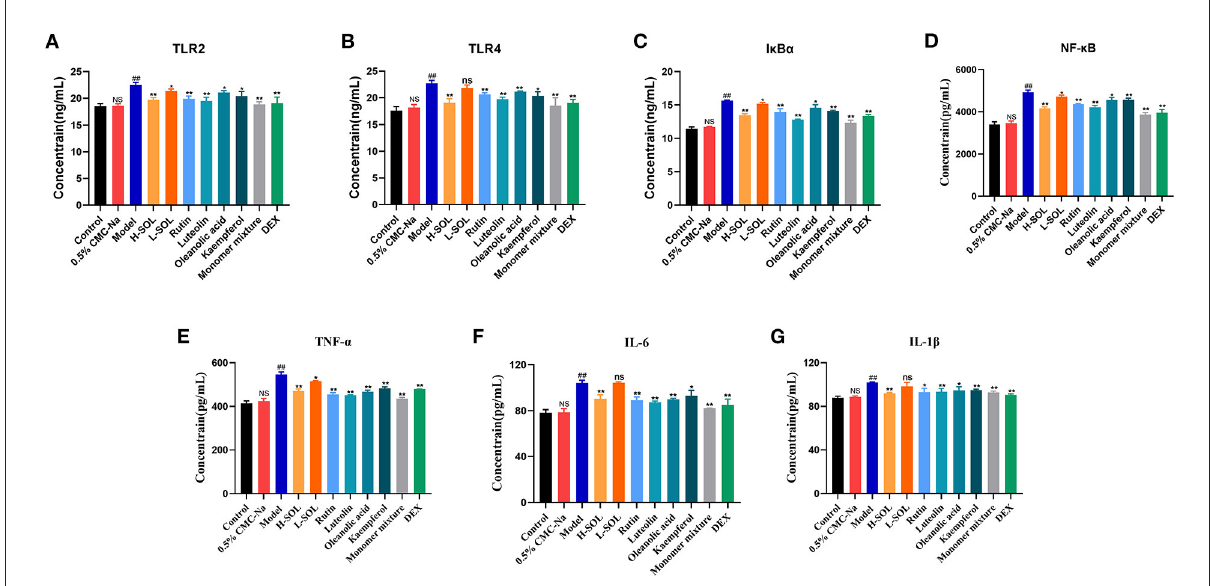
FIGURE9 ELISA analysis of TLR2 (A) , TLR4 (B) , I κ B α (C) , NF- κ B (D) , TNF- α (E) ,IL-6 (F) , and IL-1 β (G) in uterus tissues by activating TLRs/NF- κ B pathway. Data are expressed as the mean value ± standard deviation (SD). Statistical analysis is performed with the student’s t- test. ## p < 0.01, NS vs. control group; * p < 0.05, ** p < 0.01 and ns vs. model group; NS or ns: no significant